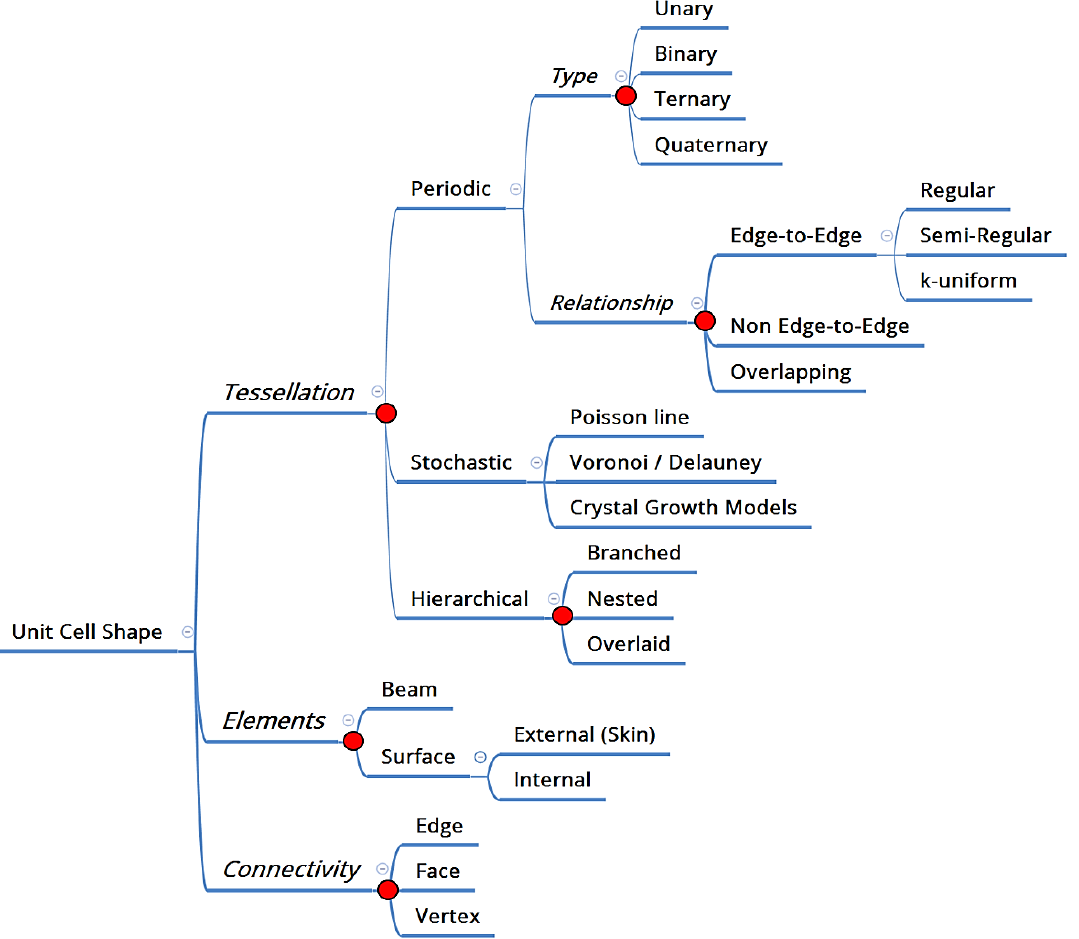
Figure 1. Classification of cellular materials unit cell design based on a three level decision-making process first proposed in reference [4].